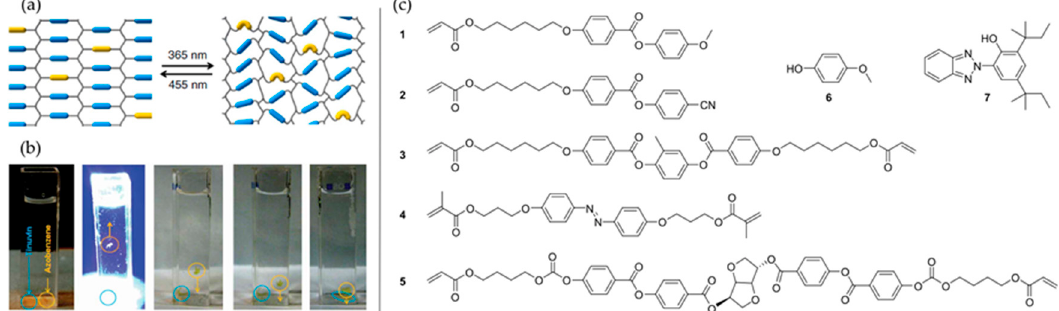
Figure 9. ( a ) The graphical representation of the polymeric network with copolymerized di-acrylate azobenzene with illumination of different wavelengths. Reproduced from [103].; ( b ) Density change in a chiral nematic polymer film containing copolymerized di-acrylate azobenzene (yellow circle) and the photoabsorber Tinuvin 328—molecule 7 above—(blue circle) before, during and after UV exposure in salt brine. Reproduced from [95]; ( c ) Chemical structures of the mixtures typically used to achieve glassy azo-liquid crystal networks (LCN) coatings. Molecules 1 – 3 make up the LCN, 4 is the azo crosslinker, 5 and 6 are a chiral dopant and radical scavenger, respectively, and 7 is a UV absorber.